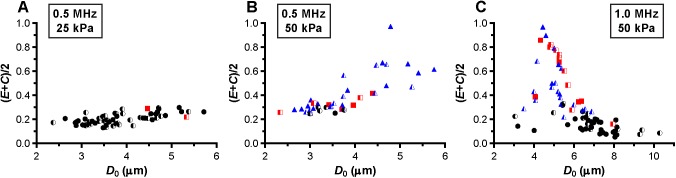
Relative vibration amplitude, (E+C)/2.For microbubbles insonified at a frequency of 0.5 MHz and a P_ of 25 kPa (A), frequency of 0.5 MHz and P_ of 50 kPa (B), and frequency of 1 MHz and P_ of 50 kPa (C). For figure legend, see the rightmost column of Fig 2 and Fig 3.